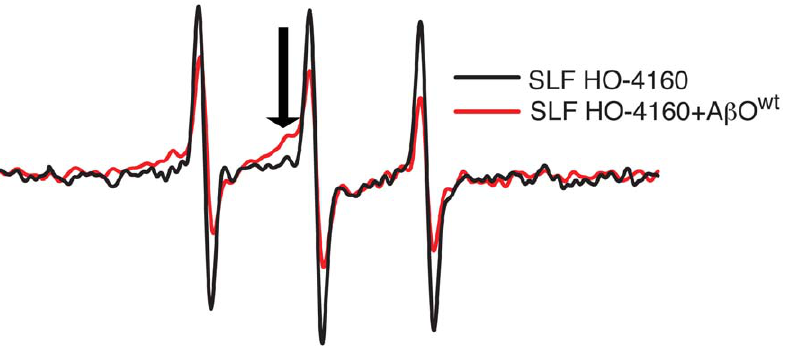
Figure 6. EPR examination indicates the motional freedom of SLF is reduced by interaction with A b O. A b O imparts a broad component (arrow) into the EPR spectrum of HO-4160, reflecting a population of SLF with a slower correlation time.